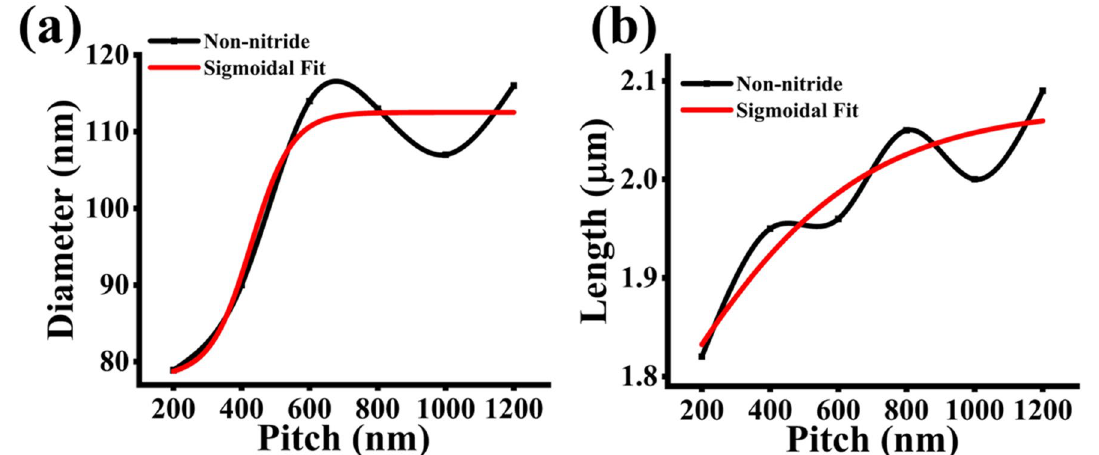
Figure 10. Sigmoidal fit results for ( a ) length and ( b ) diameter in the non-nitride sample.